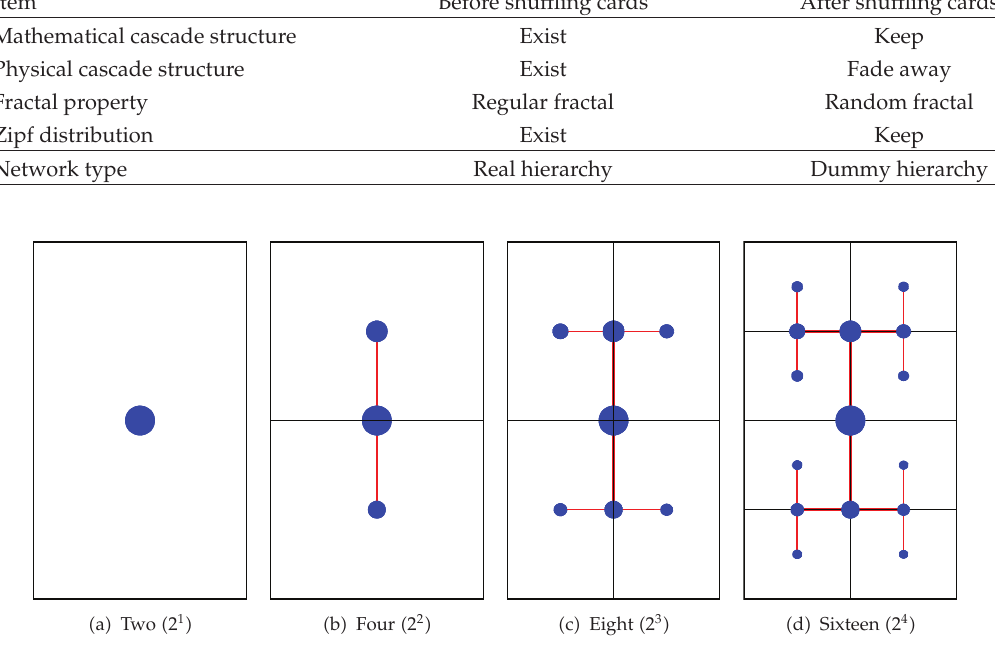
Figure 5: Spatial disaggregation and network growth (cid:6) the first four steps (cid:7) (cid:6) by referring to (cid:4) 6 (cid:5)(cid:7)